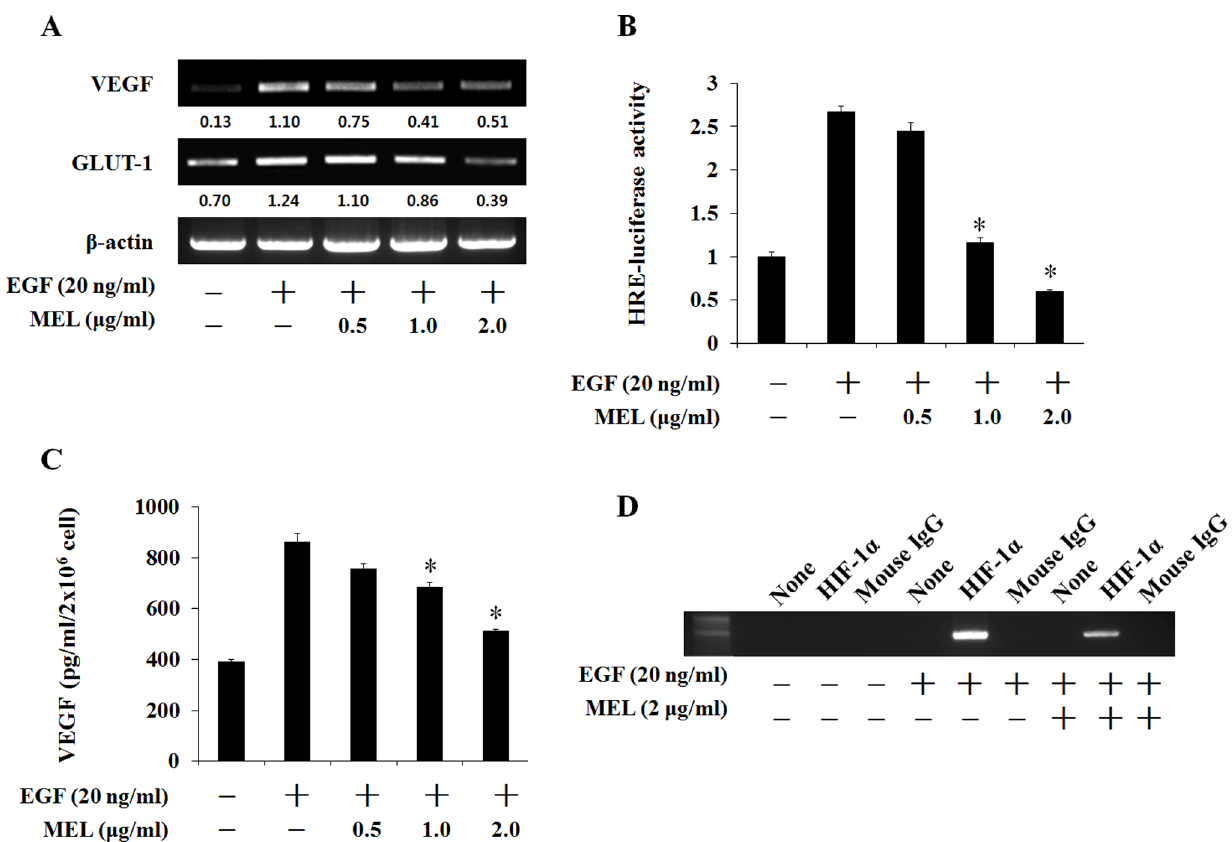
Figure 4. Melittin (MEL) abolished the expression/secretion of the EGF-induced VEGF in the CaSKi cells. (A) RT-PCR analysis of VEGF, and GLUT-1 mRNA was carried out using total RNA prepared from CaSki cells incubated with EGF treatment for 12 h in the presence or absence of the indicated concentrations of MEL. (B) CaSki cells were transiently co-transfected with a reporter gene, pGL3-HRE-Luciferase, and pRL-CMV as a reference. Following incubation for 24 h, the cells were incubated with EGF treatment in the presence or absence of indicated concentration of MEL. (C) VEGF protein expression was evaluated by ELISA in culture supernatant of CaSki cells after incubation under EGF treatment in the presence or absence of the indicated concentrations of MEL. (D) CaSki cells were treated with MEL on EGF-induced for 6 h. The immunoprecipitated DNA with mouse normal IgG and HIF-1 a antibody was amplified by PCR analysis for VEF promoter HRE region.